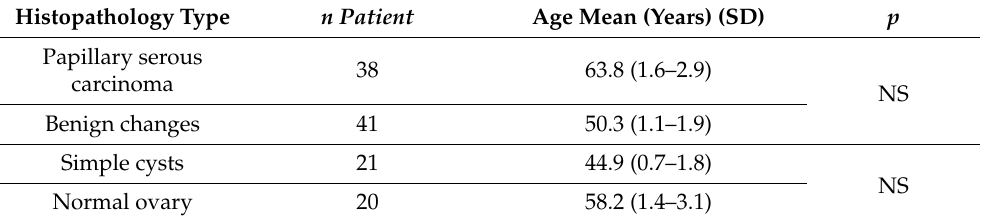
Table 1. The characteristics of each group and subgroup of patients.